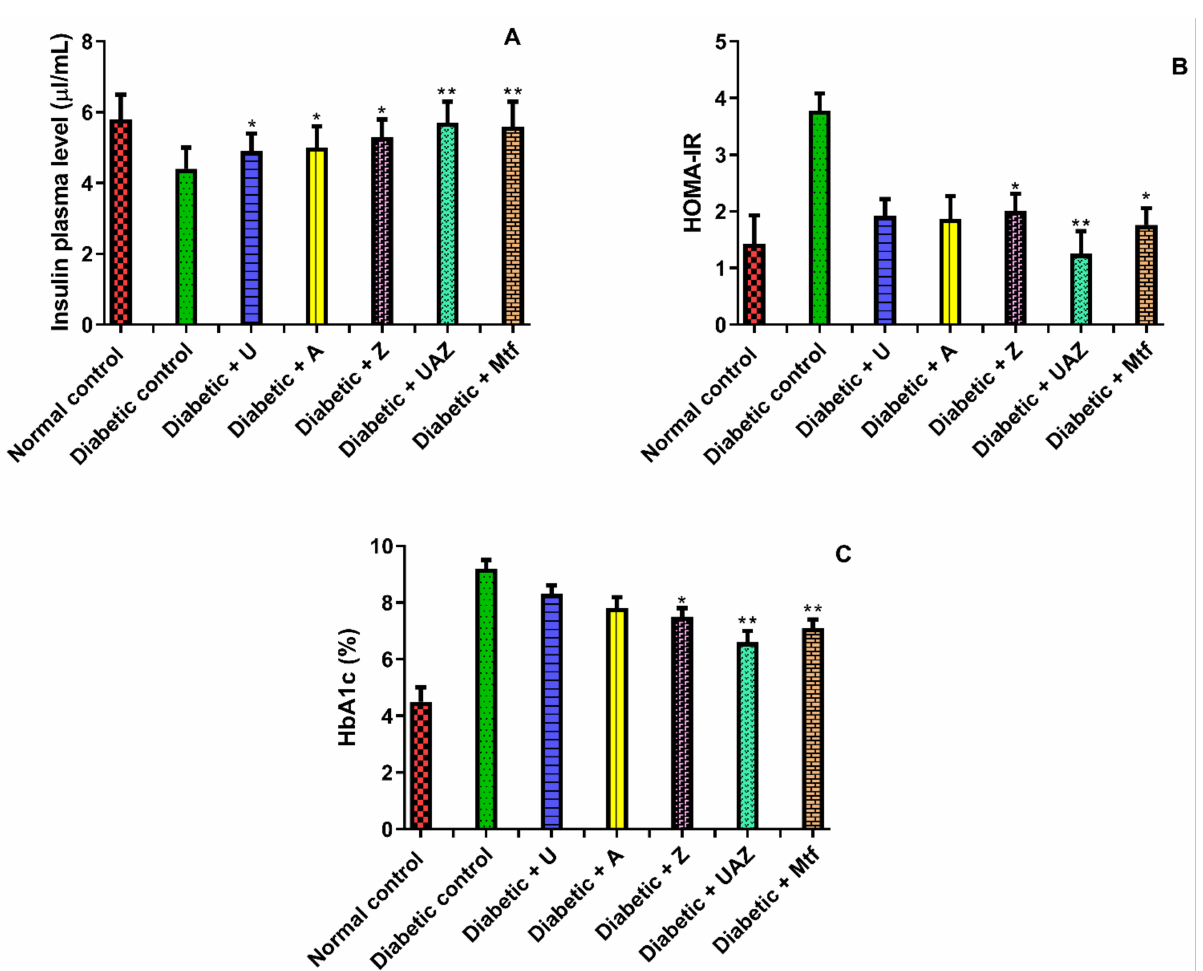
Figure 2. Values are shown as mean ± SD (n = 8). ( A ) Insulin plasma; ( B ) Insulin resistance (HOMA-IR); ( C ) HbA1c over 4 weeks of treatment (250 mg/kg). The animals were fasted 12 h before blood sampling. Metformin (Mtf; 100 mg) was administered as a positive control, and the vehicle was administered as negative control. There is a significant difference compared with the control group * p < 0.01 and compared vs. diabetic control group ** p <